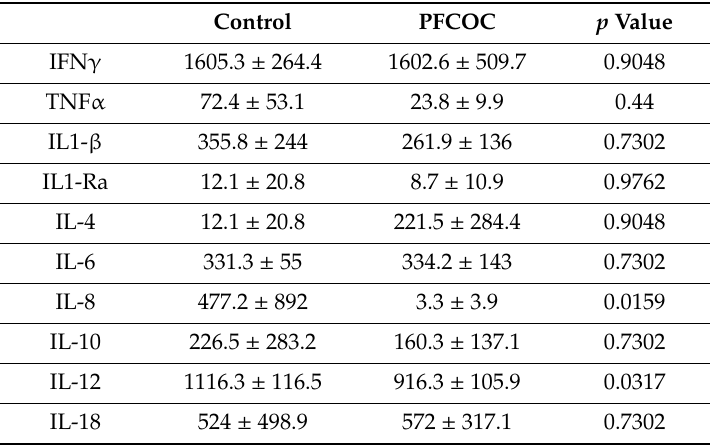
Table 2. Plasma cytokine levels at the end of 4 h reperfusion after transplantation. Control PFCOC